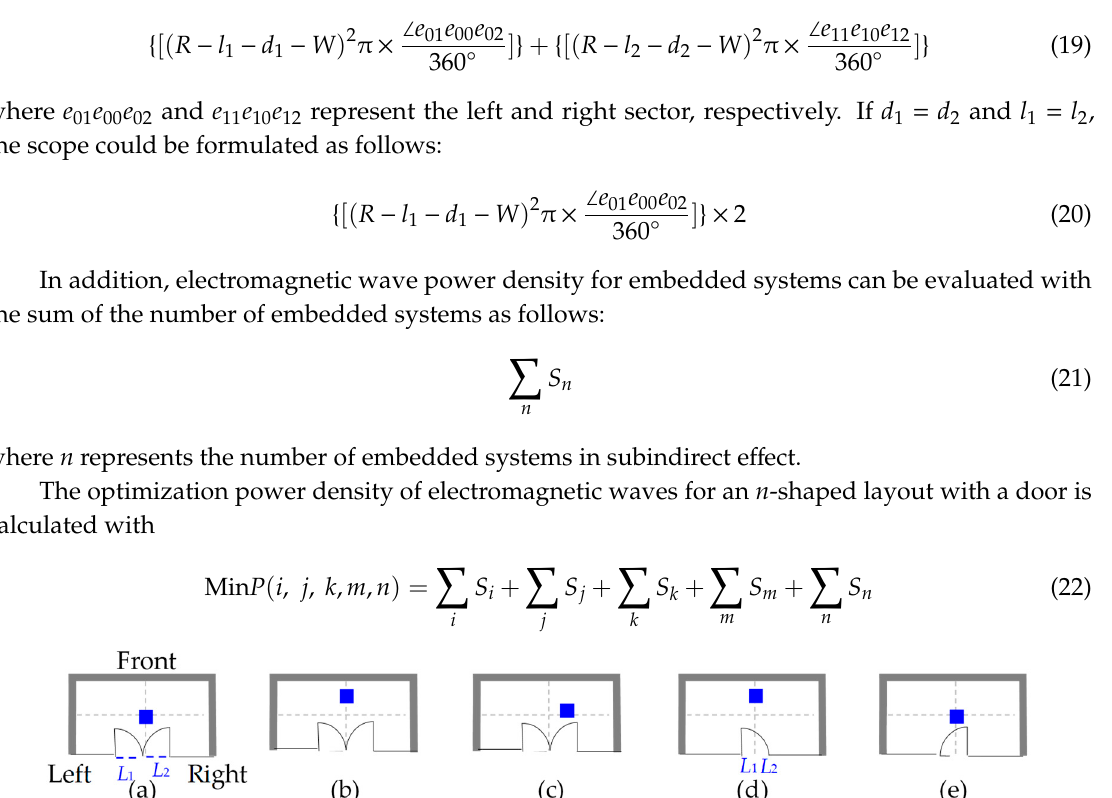
Figure 8. Variant locations of the communication center in an n -shaped layout with a door. ( a – c ) demonstrates three kinds of n -shaped communication center layouts with a wider door. ( d , e ) displays two kinds of communication center layouts in an n shape with a narrower door.